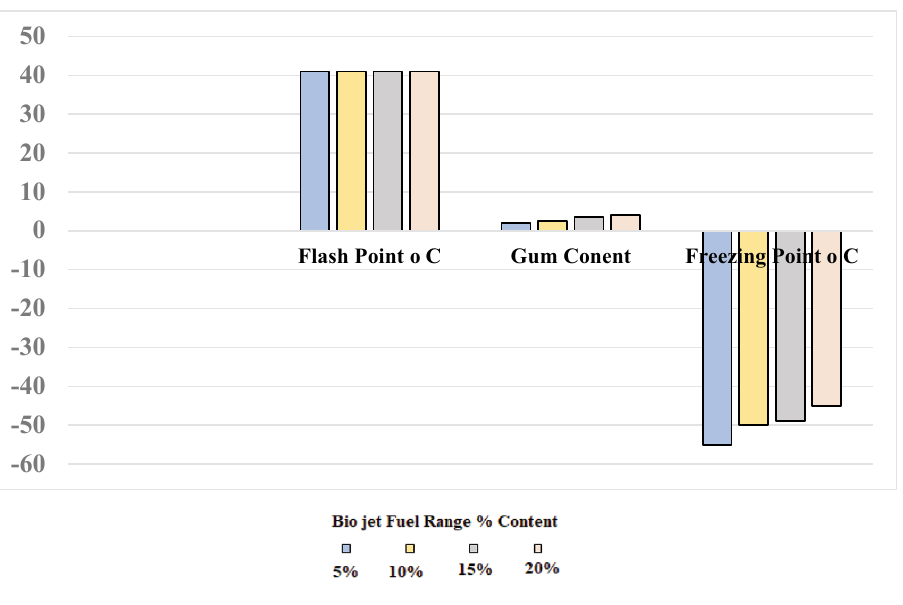
Figure 10. Physical properties of binary jet A-1 blends with different ratios of bio jet fuel product range and jet